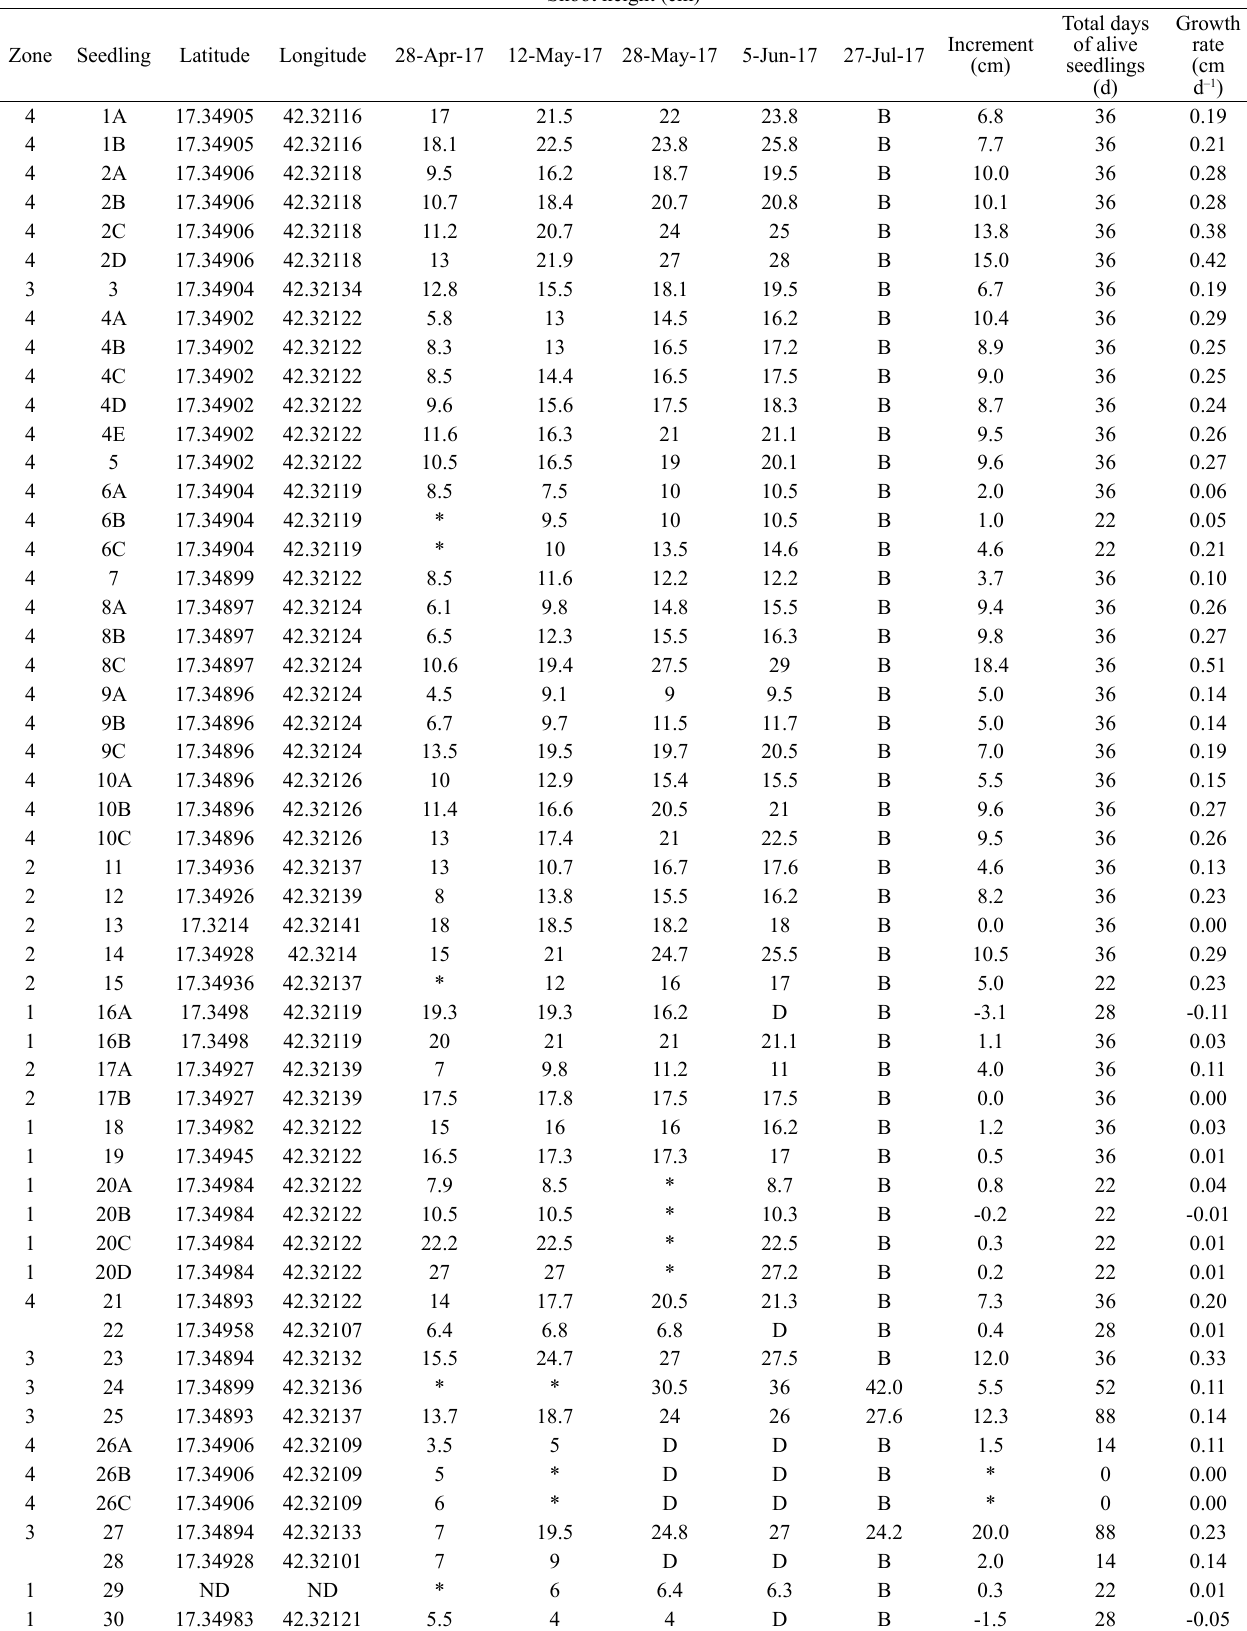
Table 1. – Growth measurements, increments (cm), total days of alive seedlings (day, d), growth rate (cm d –1 ) and location of mangrove seedlings examined in Baish, Jizan, Saudi Arabia (Red Sea). ND, not determined; *, not measured; D, dead; B,